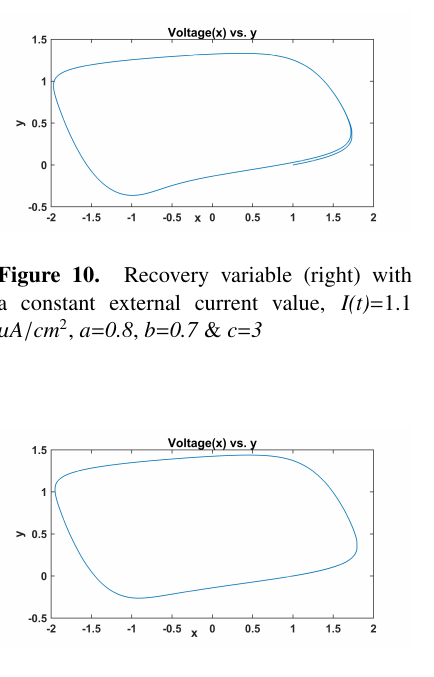
Figure 11. Responses of membrane potential with a constant external current value, I(t) = 1.5 µ A / cm 2 , a = 0.8 , b = 0.7 & c = 3